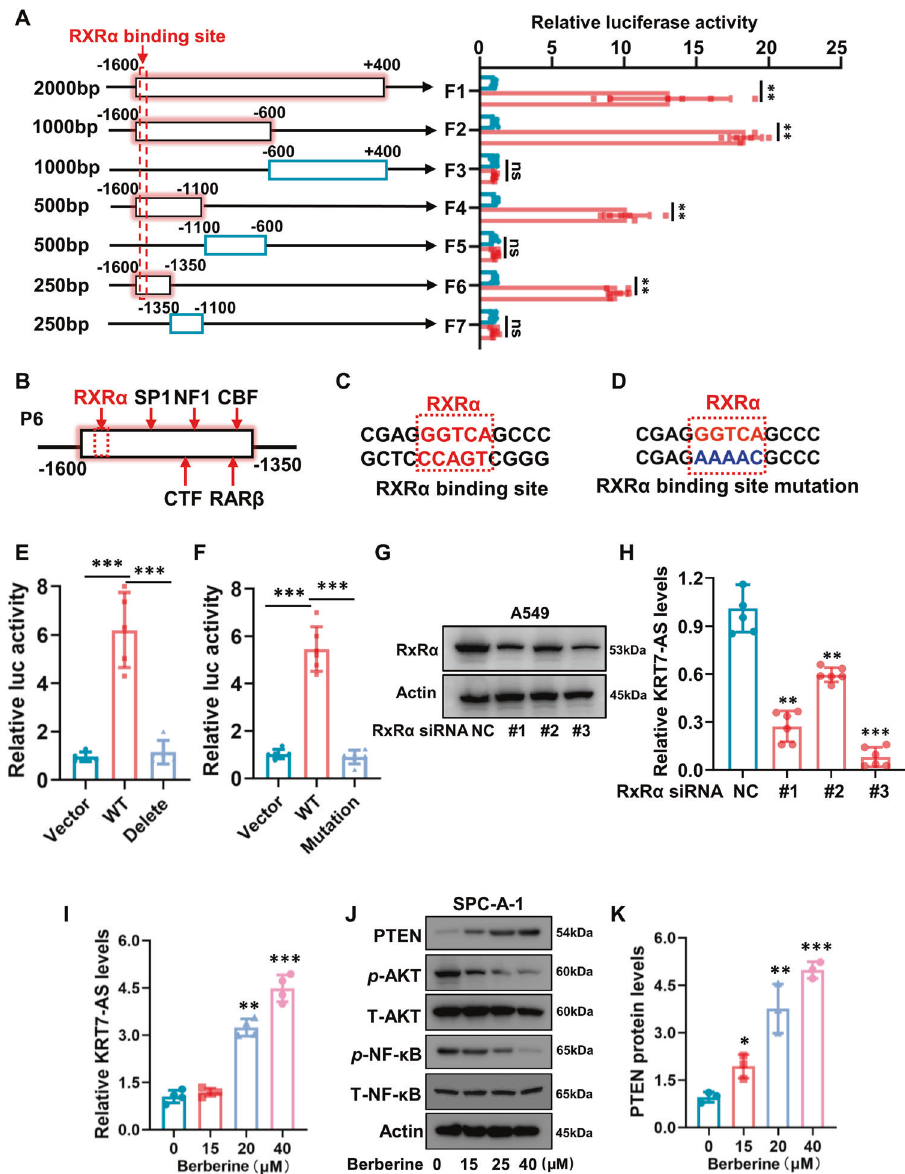
Fig. 3 RXR α drives the transcription of KRT7-AS and the RXR α agonist berberine promotes KRT7-AS expression. The KRT7-AS genomic DNA fragment ( − 1600 to + 400) from the transcription initial site was separated into seven fragments ( A , left panel). Luciferase assay showed that the fragments which contain the transcription factor RXR α -binding site had promoter activity ( A , right panel), and indicated that the promoter DNA from − 1600 to − 1350 from the transcription initial site was the shortest fragment with strong promoter activity ( A , B ). LASAGNA method indicated that the DNA fragment from -1600 to -1350 has six putative transcription factor binding sites ( B ), The core nucleic acids GGTCA in wild type of RXR α -binding site in the sub-fragment P6 ( C ) was mutated to AAAAC ( D ). Luciferase assay showed that both deletion and mutation the core nucleic acids CGAGGGTCAGCCC in the RXR α -binding site lost the promoter activity ( E , F ). RXR α levels were detected in RXR α -silenced A549 cells ( G ). KRT7-AS levels were detected in RXR α -silenced A549 cells ( H ). The RXR α agonist berberine signi fi cantly increased KRT7-AS transcription levels ( I ), and concurrently raised PTEN protein levels ( J , K ). Data are shown as mean ± SD of three independent replicates. * P < 0.05, ** P < 0.01, *** P <